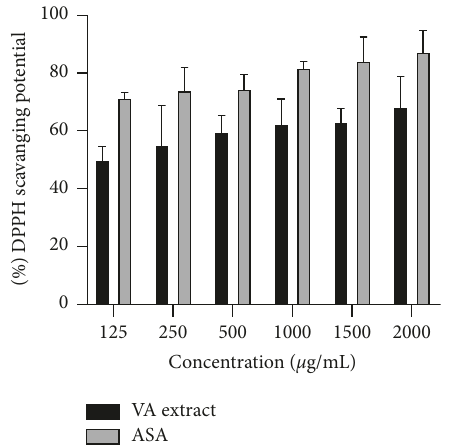
Figure 1: % DPPH radicals scavenging potential of V. album extract and Ascorbic acid.